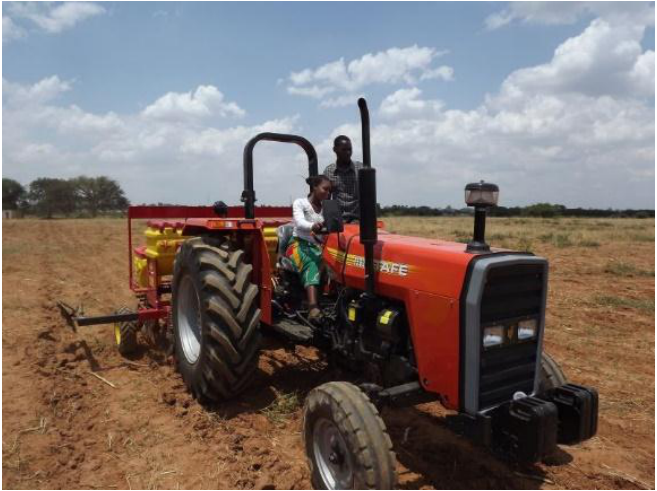
Figure 3. Training in field operation of a tractor-mounted no-till planter.